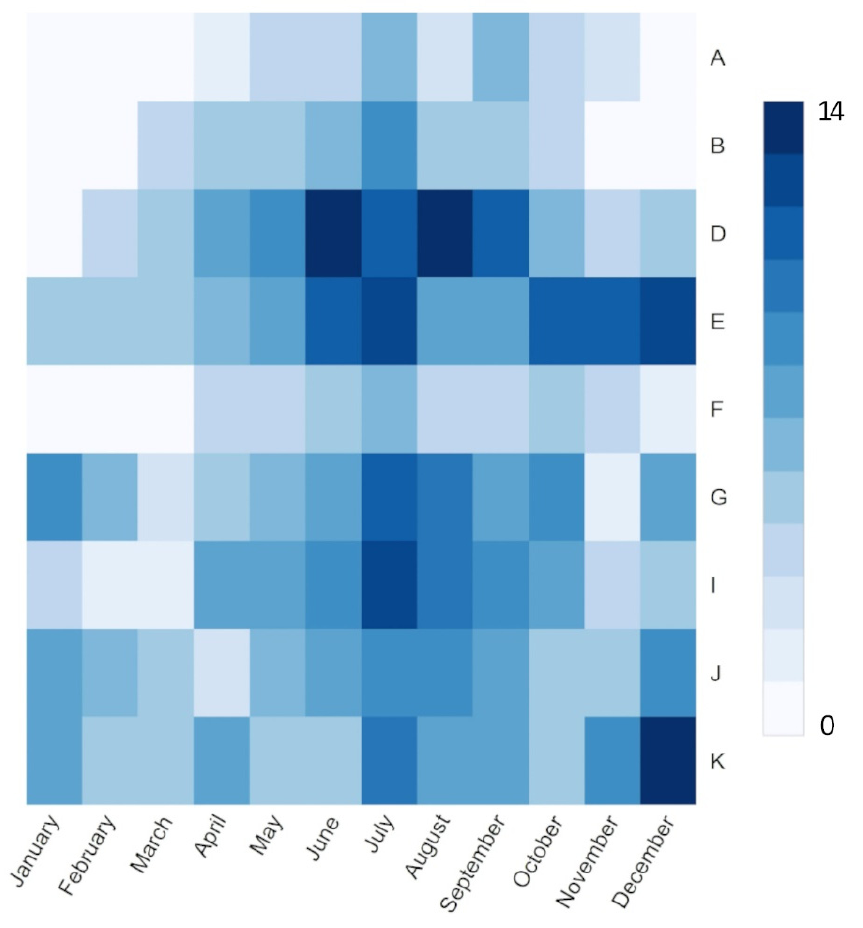
Figure 2. The average number of cloud-free PlanetScope images per month across the study sites. The study sites are denoted using the site letters in Figure 1.